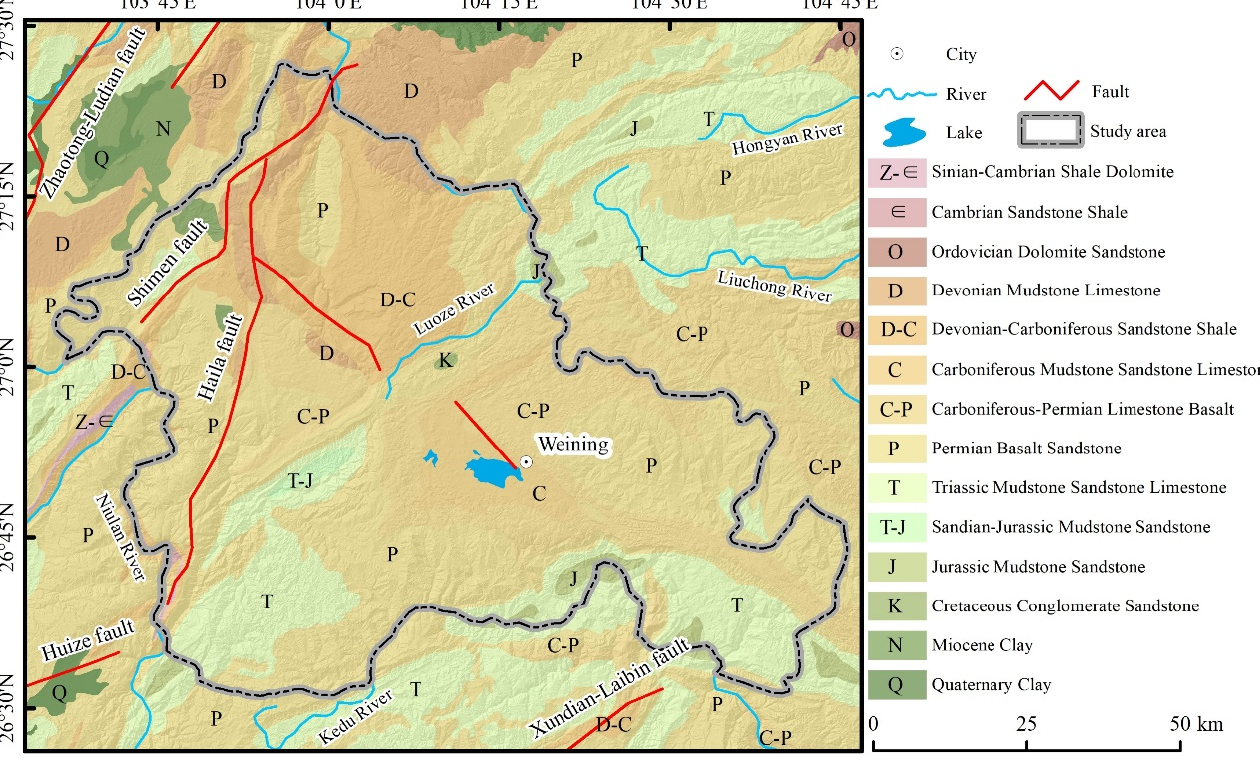
Figure 2. Geological map of the study area.